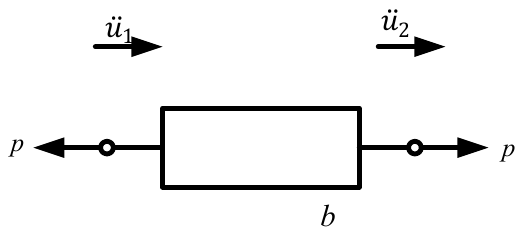
Figure 3. Schematic drawing of inerter element.